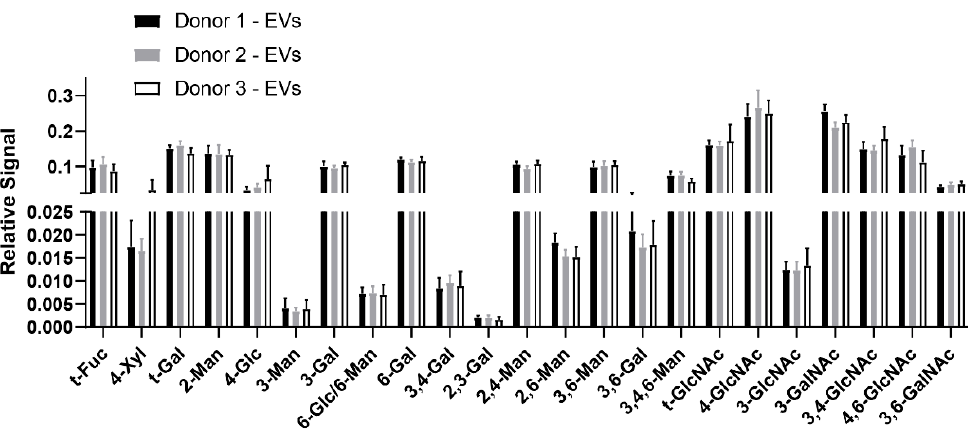
Figure 6. Comparison of EV glycan node expression across donors. Data represent XIC peak areas for each hexose or HexNAc within each sample, that were normalized to the sum of all hexose or HexNAc XIC peak areas for that sample. For each glycan node, di ff erences between all pairwise combinations of donors were searched for with t-tests, using the two-stage linear step-up procedure of Benjamini, Krieger, and Yekutieli, with Q = 0.1% to correct for false discoveries. No significant di ff erences were observed. Data represent mean ± s.d. ( n = 8).